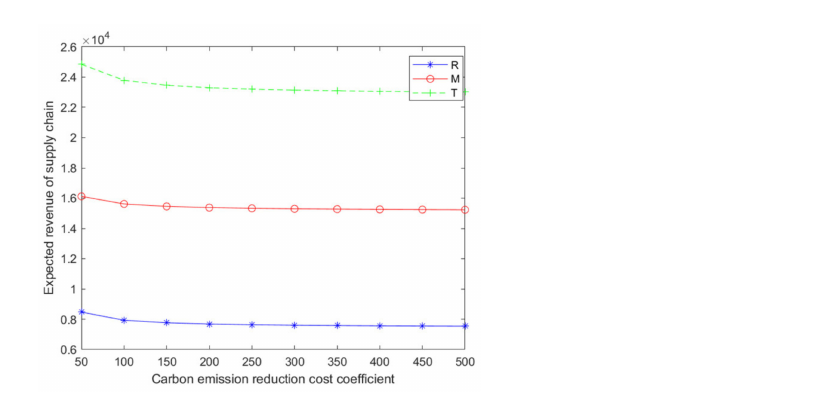
Figure 5. The impact of the carbon emission reduction cost coefficient on the benefits of electricity producers, retailers, and the entire supply chain under the condition of decentralized decision making in the supply chain.